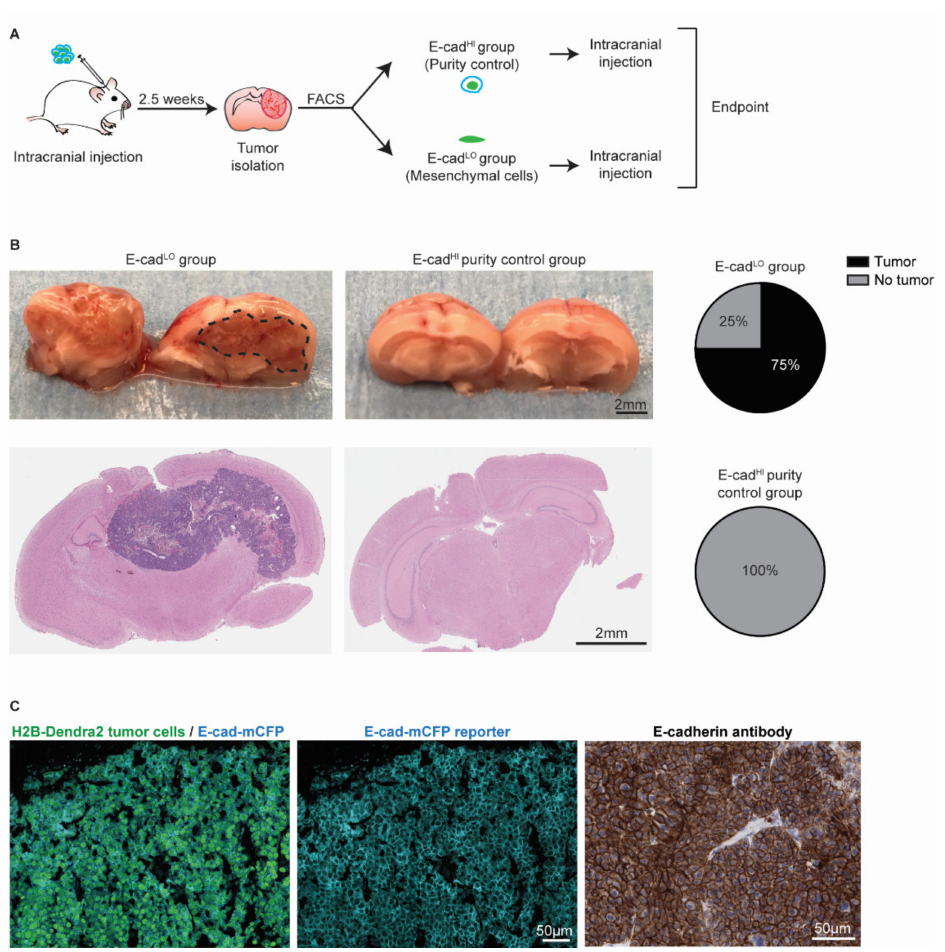
Figure 6. Mesenchymal cells can grow tumors and revert to an epithelial state. ( A ) Schematic repre- sentation of experimental design. ( B ) Representative pictures and H&E staining of the mouse brain. Pie charts show the percentage of BCBM tumors formed after intracranial injection of approximately 2000 E-cad LO tumor cells compared to the purity control group. n = 4 mice per group. ( C ) Represen- tative images of immunofluorescent staining (left and middle panels) of H2B-Dendra2 (green) and the endogenous E-cad-mCFP (turquoise) reporter in tumors formed after intracranial injection of E-cad LO tumor cells. The expression of E-cadherin was confirmed using immunohistochemistry with an E-cadherin antibody (right panel). n = 3